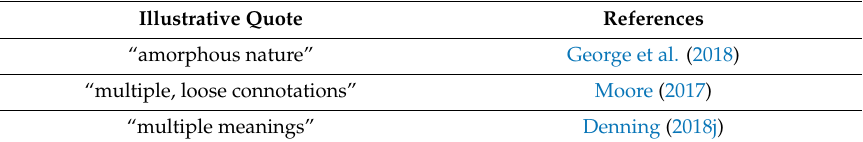
Table 2. The interpretive space of the Agile